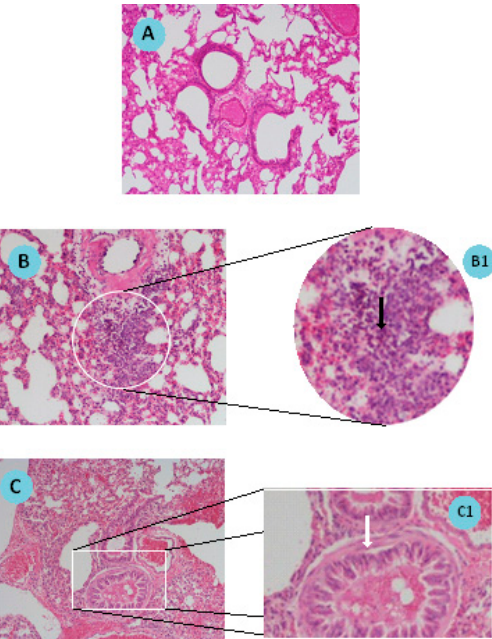
Figure 7. Sections of mouse lung ( A ) non-induced (Control); ( B , C ) chicken ovalbumin (OVA) / Aluminum sensitized / challenged. B1 and C1 are close-up images of B and C sections, respectively. Tissue sections were stained by hematoxylin-eosin standard procedure and observed by microscopy (magnification: A, B and C: 100 × ; B1 and C1: 400 × ). B1 black arrow indicates neutrophil infiltration; C1: White arrow indicates smooth muscle layer hyperplasia.